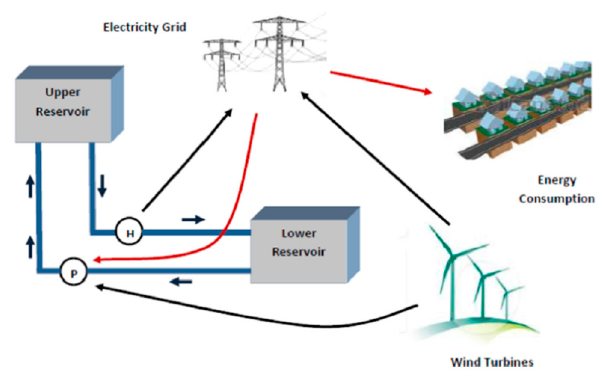
Figure 1. Structure of a hybrid power station [19].